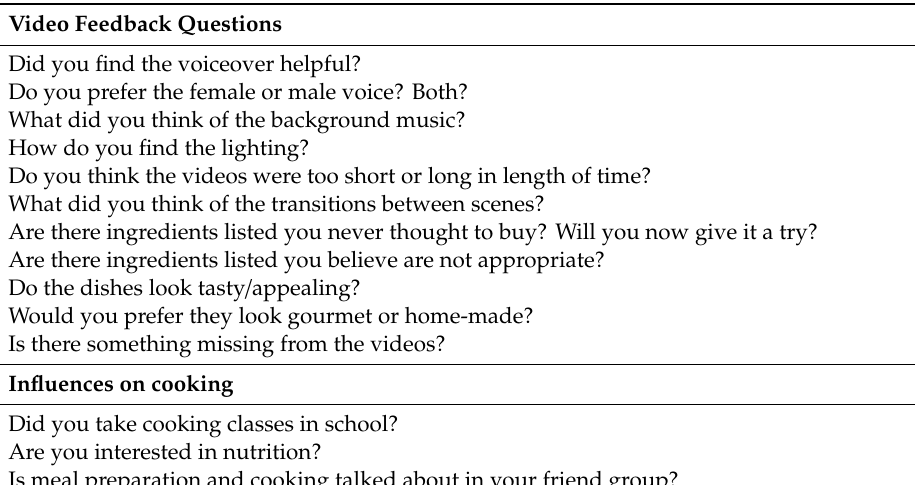
Table 2. Questions Used to Guide the Focus Group